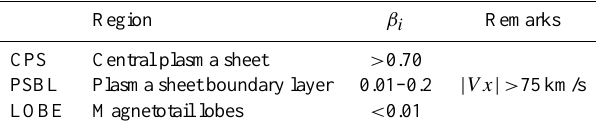
Table 2. Plasma β i thresholds used to determine plasma regimes. See also Table 1 of ( ˚Asnes et al.,